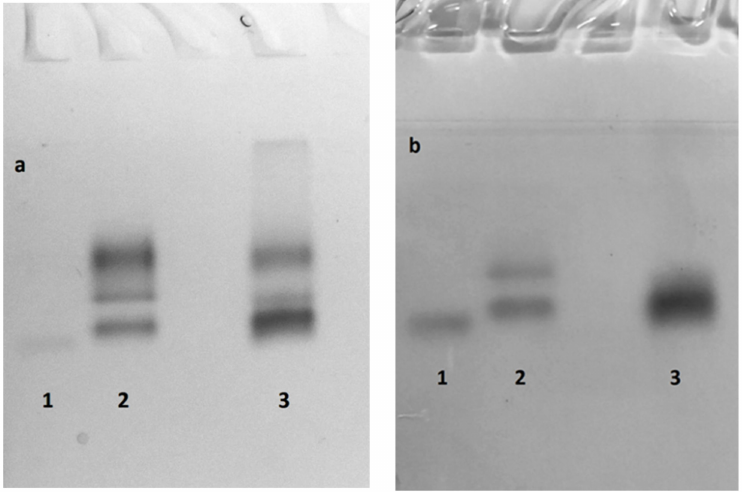
Figure 7. Zymogram of ligninolytic enzymes from G. lucidum culture medium at 14 days of cultivation. The gel was stained: with ABTS ( a ), and with TMPD ( b ). Lanes: 1—SL cultivation without agitation; 2—SM cultivation with agitation with 2% CS lignin supplement; and 3—SL cultivation without agitation with 2% CS lignin